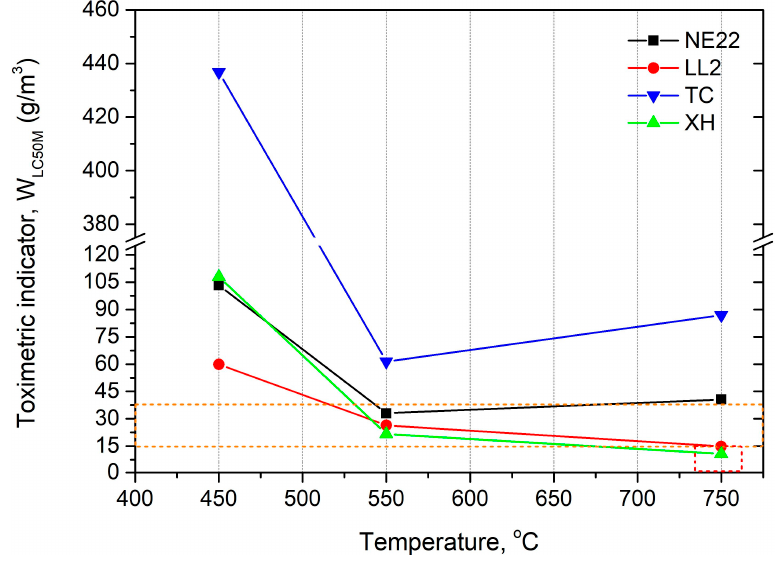
Figure 7. The toxicometric indicator ( W LC50M ) of belts as a temperature function.